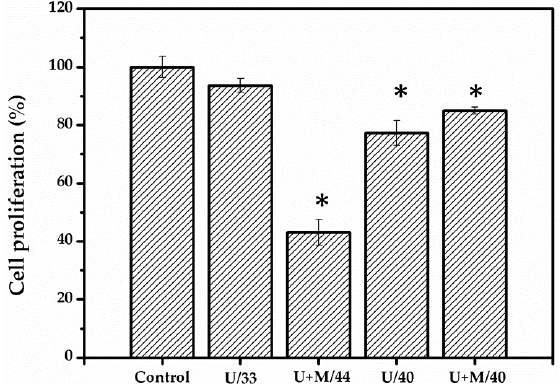
Figure 4. Cell proliferation results of ultrasound - treated N2A cells. Nontreated cells are designated as the control, U/33 is ultrasound-treated cells at 33 °C, U+M/44 is ultrasound-treated cells combined with warming biomaterial at 44 °C, U/40 is ultrasound-treated cells at 40 °C, and U+M/40 is ultrasound-treated cells combined with warming biomaterial at 40 °C.